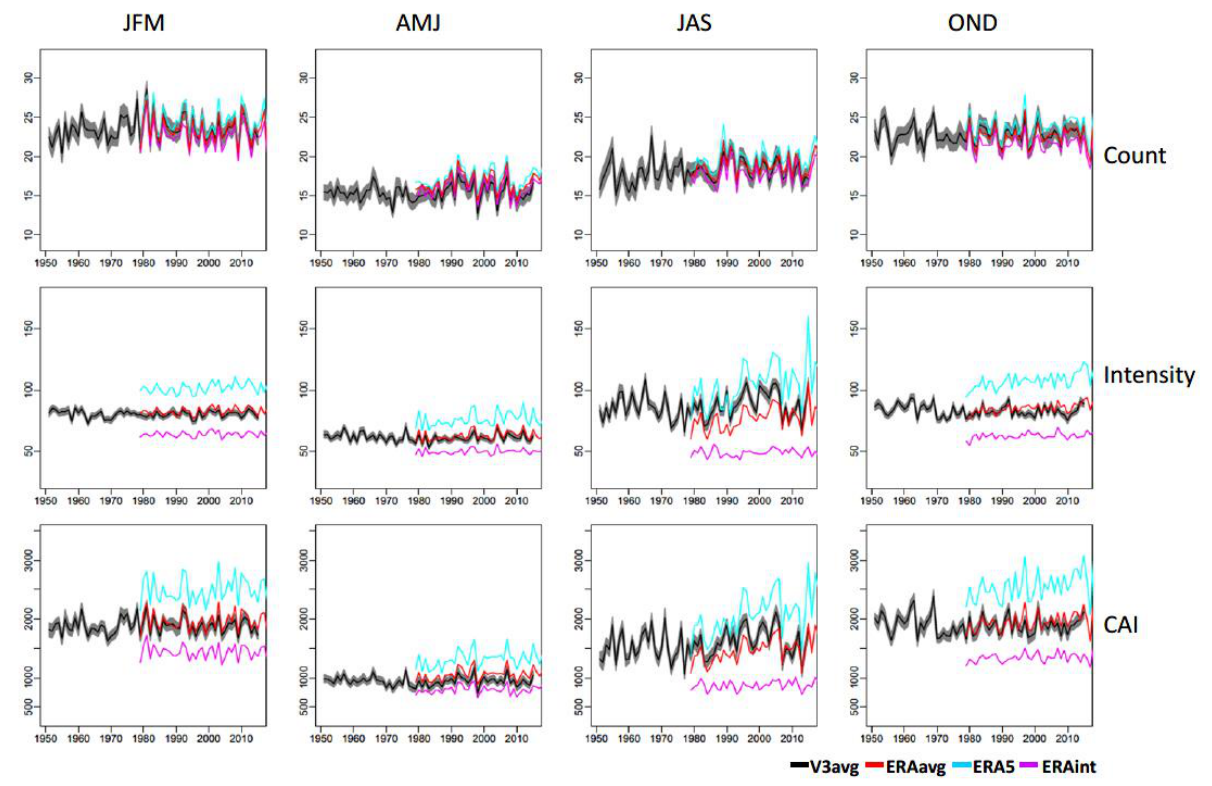
Figure 5. As in Figure 4, but for the results over the northern extratropical ocean.